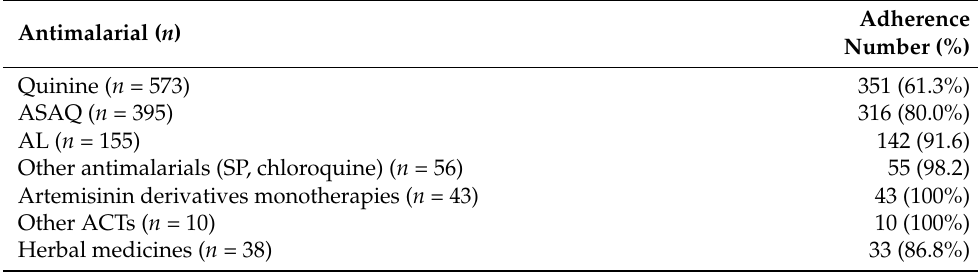
Table 3. Adherence to different malaria treatments.